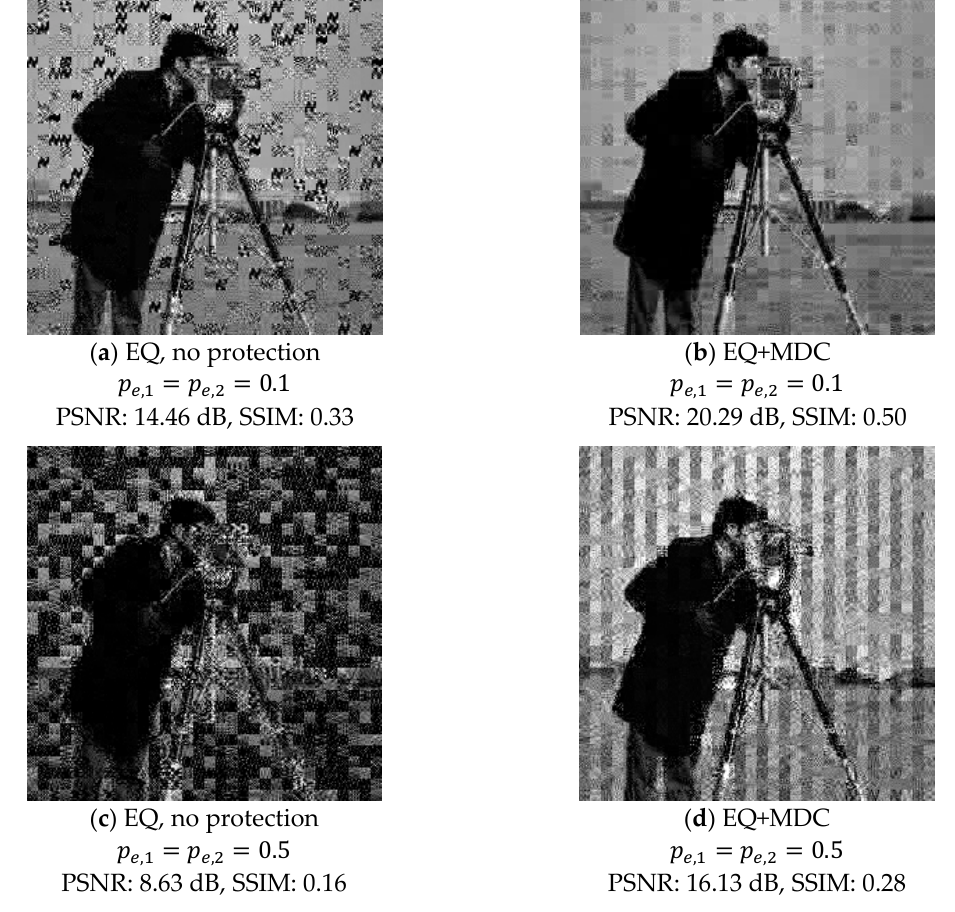
Figure 4. Reconstruction of BCS coefficients with equality constraint over lossy channels.